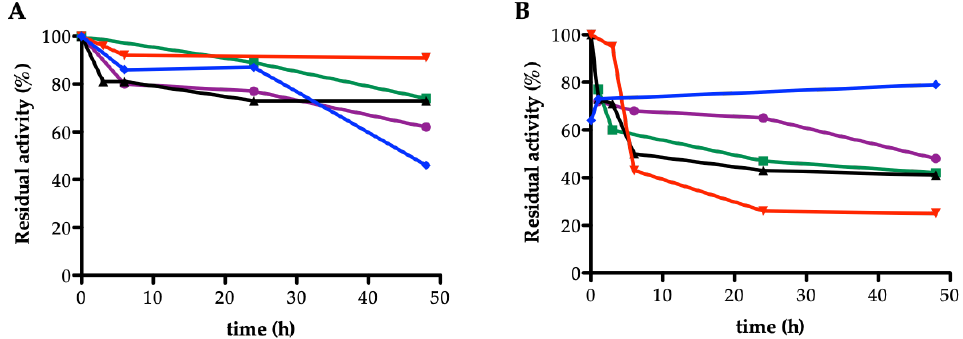
Figure 1. Stability of soluble acetyl xylan esterase from Bacillus pumilus (AXE) ( A ) and immobilized AXE on acrylic epoxy resin ( B ) in di ff erent organic co-solvents at di ff erent percentages v / v : 15% acetonitrile (purple circles), 30% acetonitrile (green squares), 50% acetonitrile (black triangles), 90% ethanol (red triangles), 90% tert-butanol (blue rhombus). The measurements were performed in duplicate.